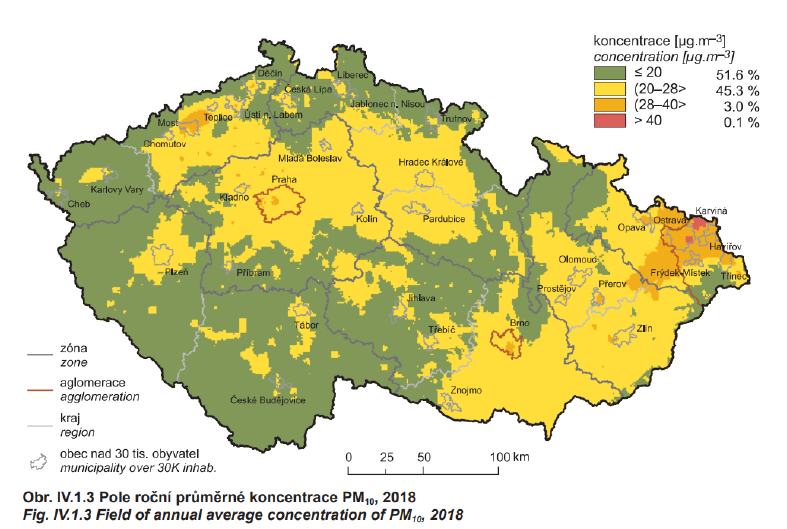
Figure 2. Annual mean concentration of PM 10 in the Czech Republic